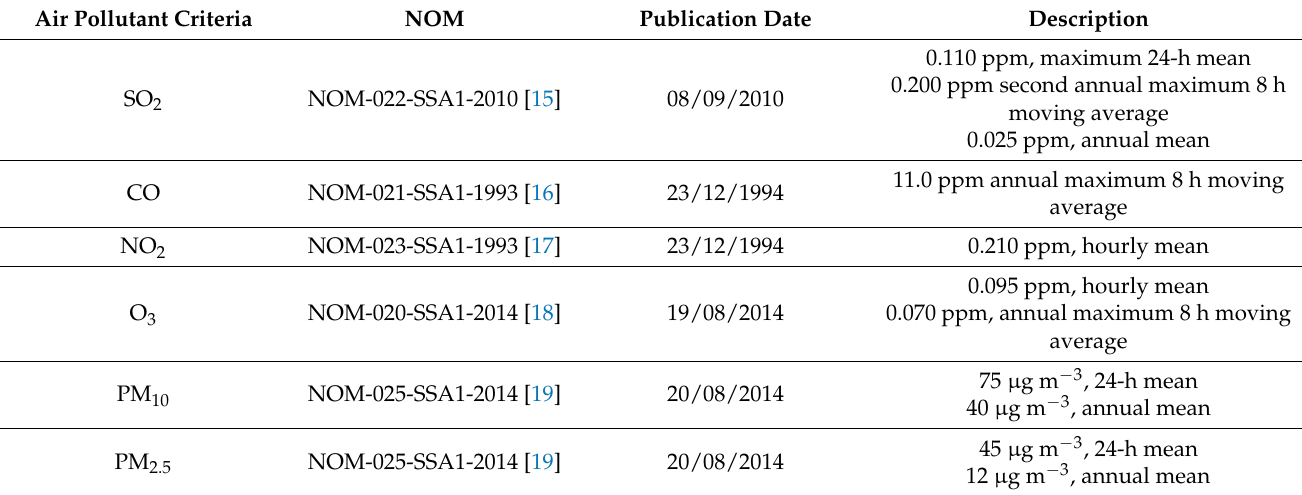
Table 1. Mexican air quality standards and their maximum permissible limits for each pollutant criteria.